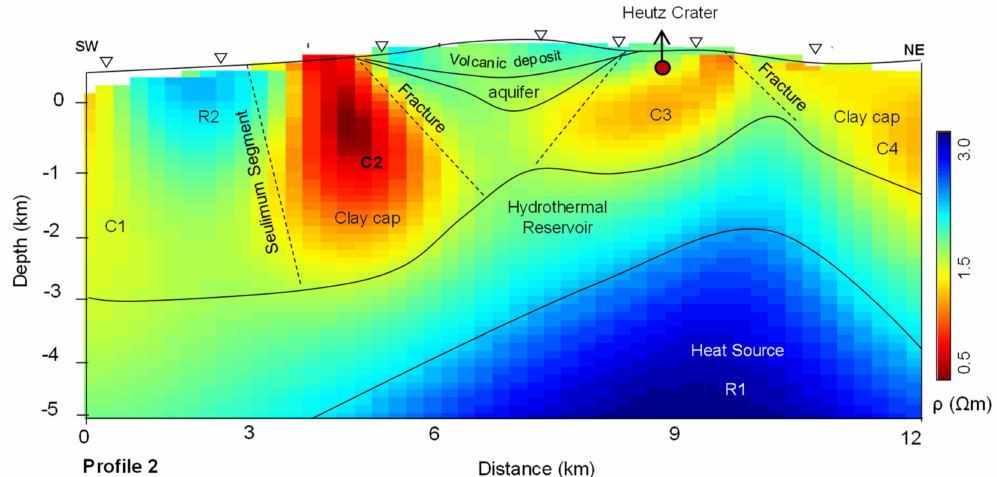
Figure 9. Two-dimensional resistivity model obtained from the Occam inversion on Profile 2 covers several local and regional faults and the Heutsz crater area. The conductors in this area are closely related to geothermal energy in the Seulawah Agam